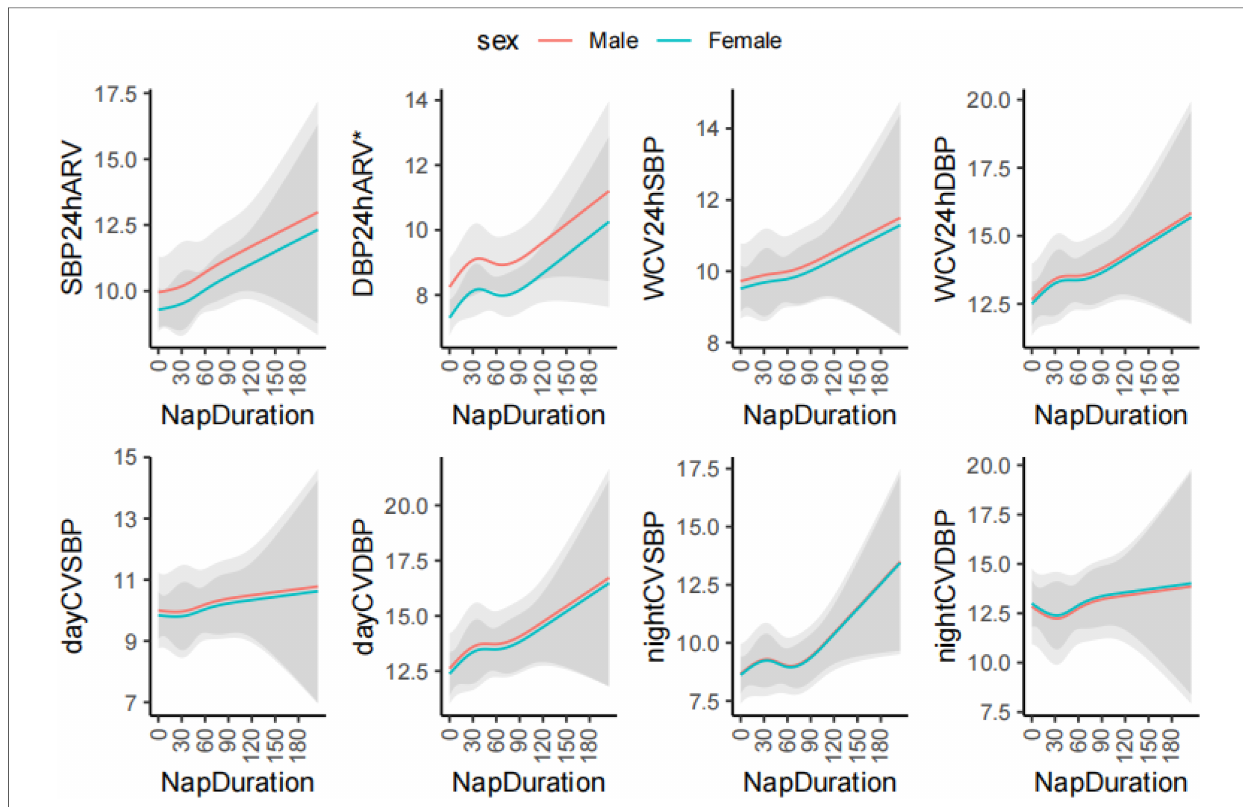
FIGURE 2 The restricted cubic spline analysis of association between nap duration and blood pressure variability. ARV, average real variability; DBP, diastolic blood pressure; SBP, systolic blood pressure; SD, standard deviation; CV, coef fi cient of variation; W, Means weighted. * P <0.05. The cubic spline model was adjusted for age.